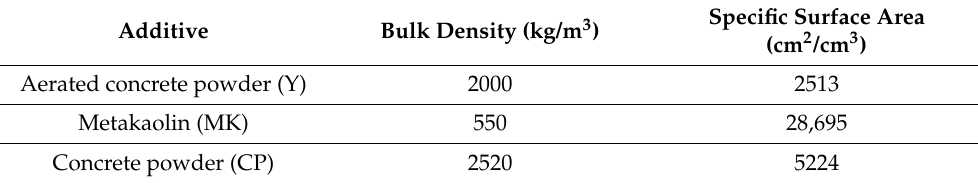
Table 3. Bulk density and specific surface area of the applied additives. Additive Bulk Density (kg/m 3